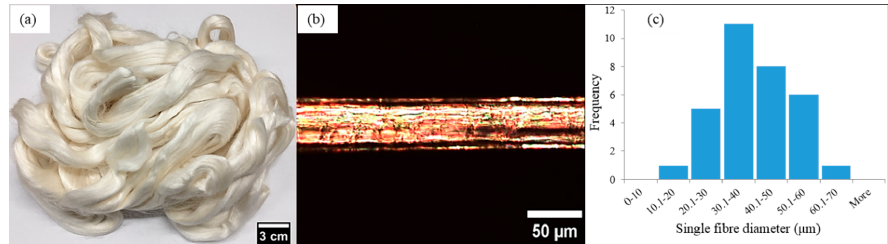
Figure 1. Ramie fibers ( a ) supplied bundle of ramie fibers, ( b ) optical microscopy image of single ramie fiber, and ( c ) histogram shows the most frequented diameter for single fibers, measured using optical microscopy images such as in ( b